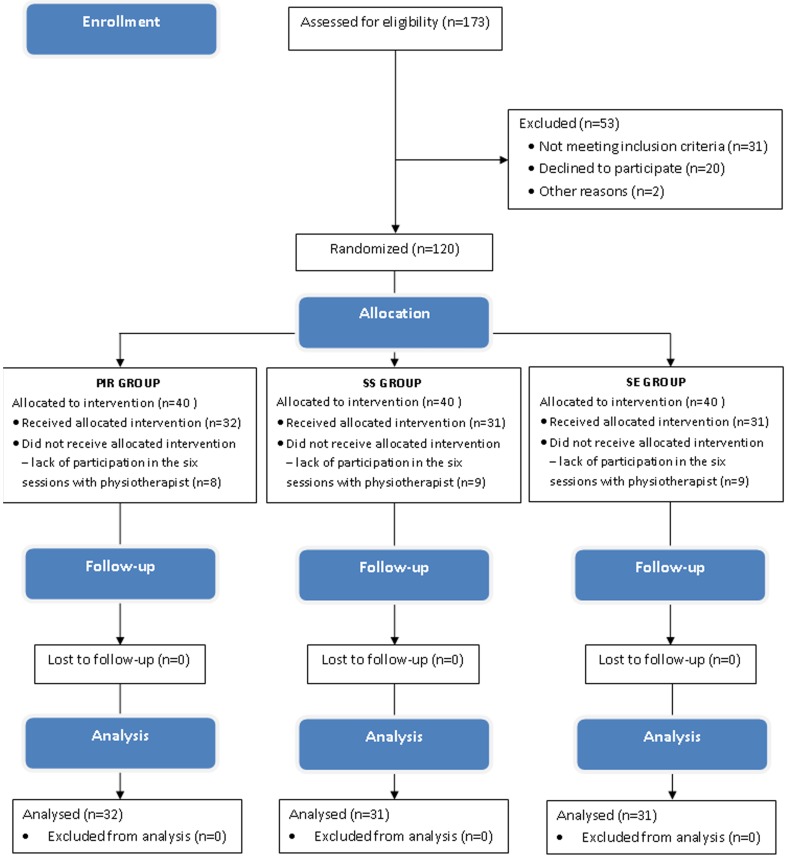
The protocol of the study.